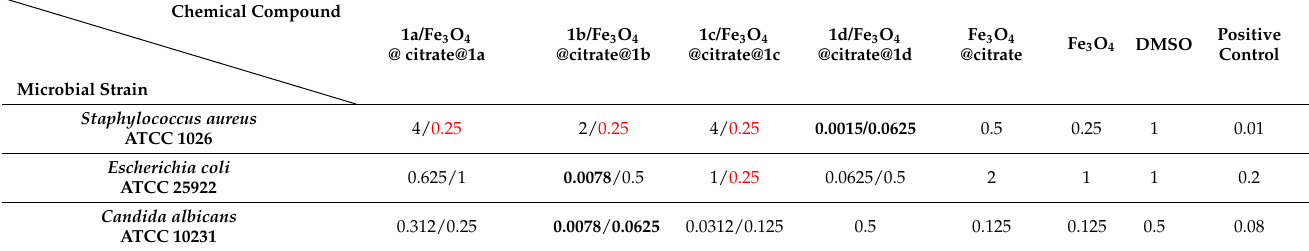
Table 2. Antibiofilm activity test results and corresponding MBEC values